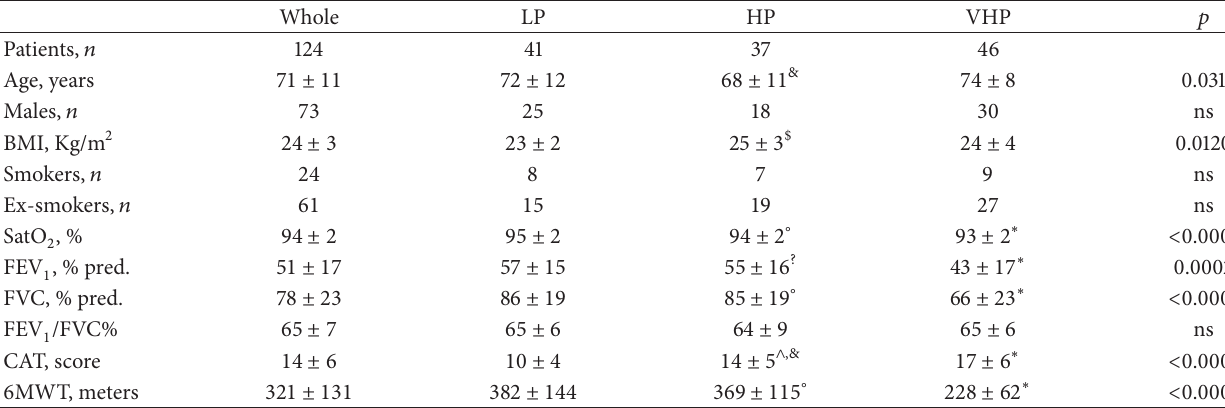
Table 2: Demographic, anthropometric, and functional characteristics of study